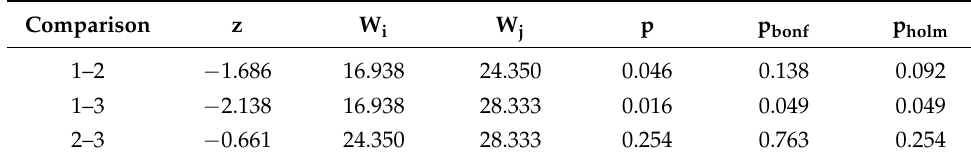
Table 2. Dunn’s post hoc comparisons in satisfaction across pathologies